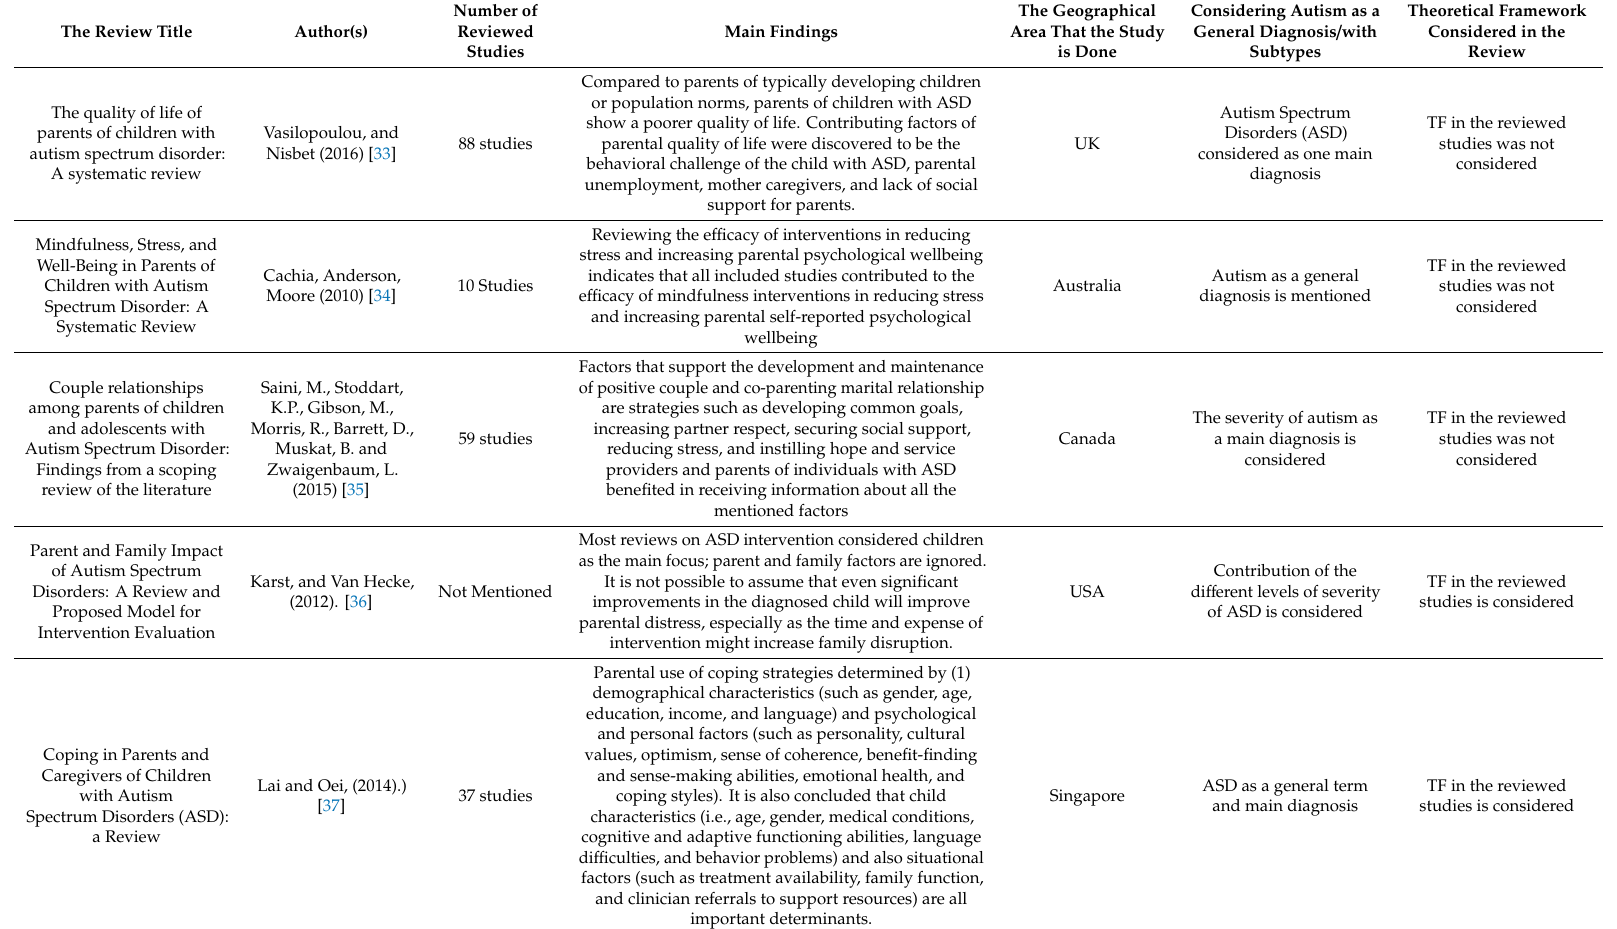
Table 1. Reviews about impacts of caregiving on parents of children with an Autism Spectrum Disorder